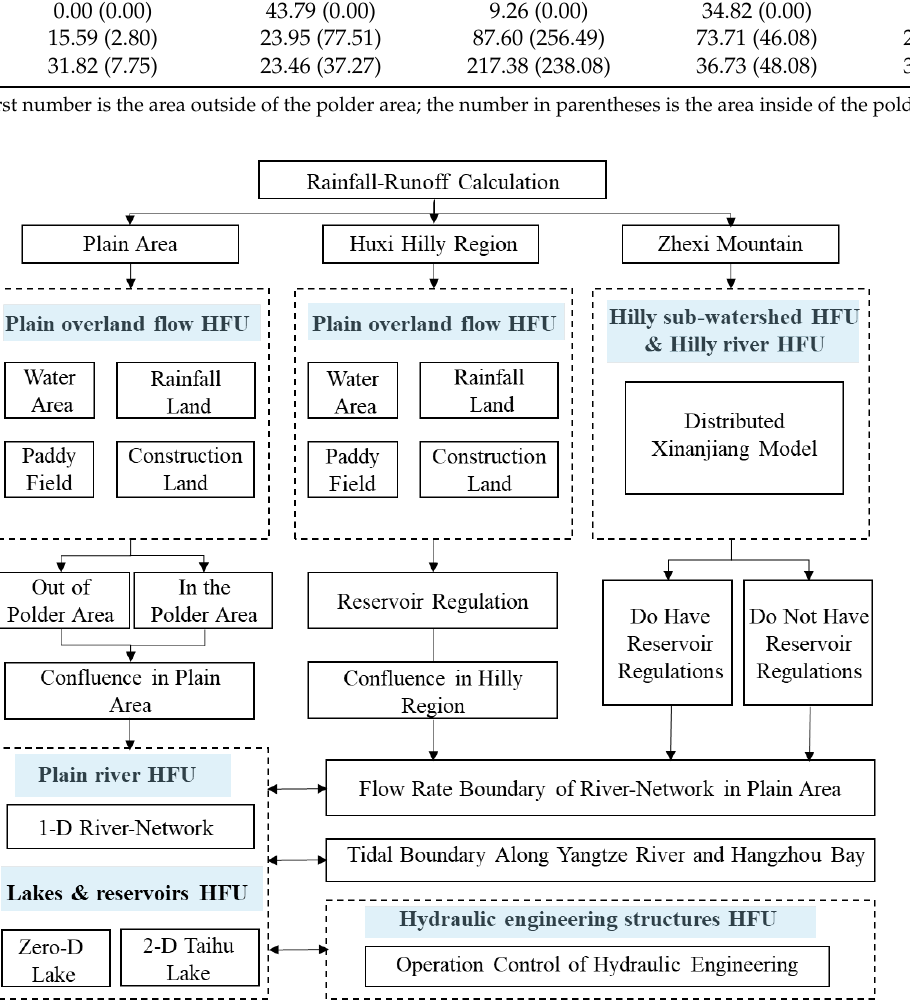
Table 4. Main generalized information for hydrological feature units (HFUs) in Taihu Basin. Type of Hydrological Feature Unit (HFUs)